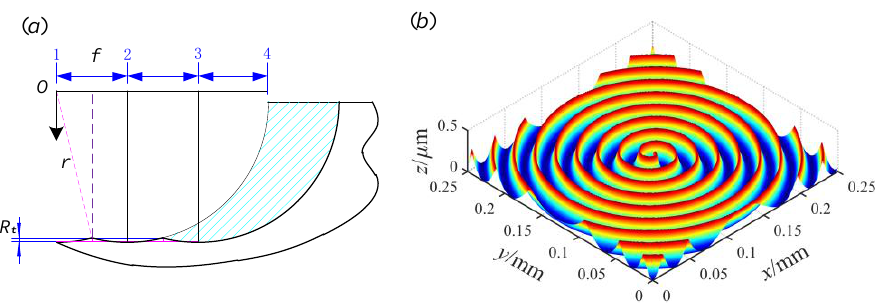
Figure 1. Turning mode. ( a ) The schematic diagram of the modeling principle; ( b ) 3D turning topography under r = 0.2 mm and f = 0.2 mm/ r .